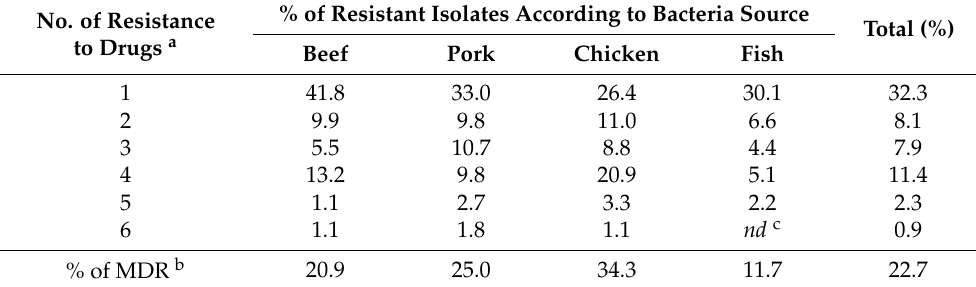
Table 3. Distribution of simultaneous antimicrobial-resistance phenotype (different drug pharmaco- logical classes) among mesophilic facultatively anaerobic Gram-negative rods isolated from meat and fish samples.